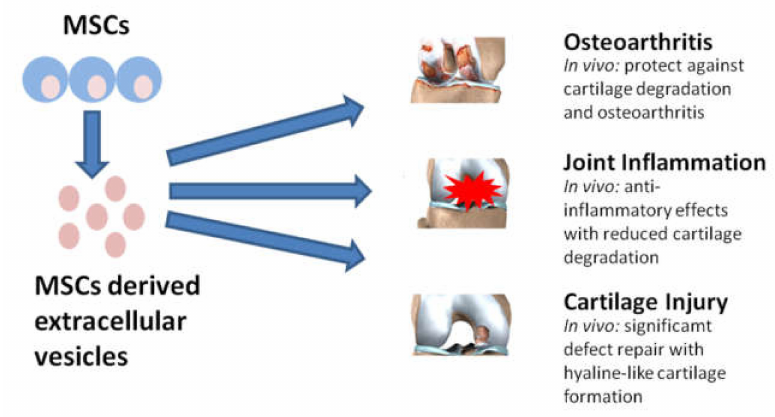
Figure 2. Regarding the human field, stem-cell-derived extracellular vesicles (EVs) can exert a multitude of beneficial e ff ects in the treatment of osteoarthritis, joint inflammation, and cartilage or osteochondral injury. (Modified from Phinney, D.G.